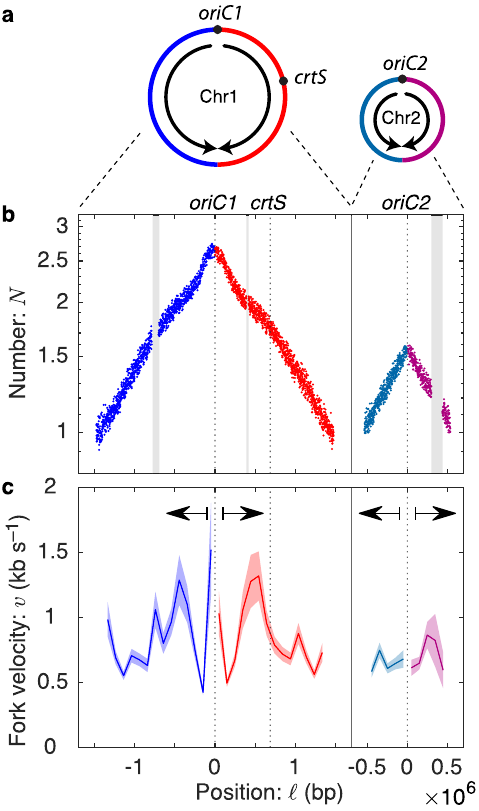
Fig. 2 | Replication fork dynamics in V. cholerae . a Chromosome organization in V. cholerae . V. cholerae harbors two chromosomes Chr1 and Chr2. oriC2 initiates shortly after the crtS sequence is replicated on the right arm of Chr1. Data color represents chromosome identity (1 or 2) and arm (R or L) and is consistent throughout thepanels. b Markerfrequencyfor V.cholerae grownon LB.Repetitive sequences that cannot be mapped result in gaps. c Fork velocity is locus- dependent. The fork velocity is shown as a function of genomic position with an error region. Statistically signi fi cant differences in the fork velocity are observed betweenloci.Thereissigni fi cantbilateral(i.e.,mirror)symmetryaroundtheorigin.